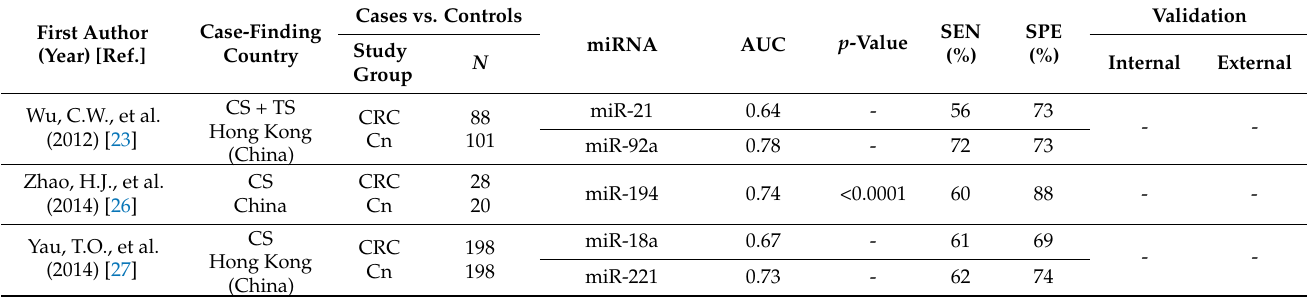
Table 1. Diagnostic performance of individual fecal miRNAs for CRC conducted in clinical